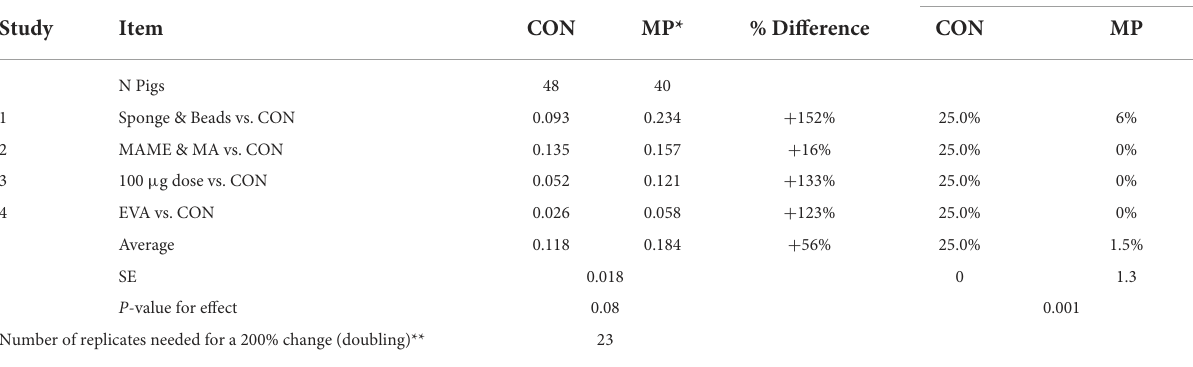
TABLE 7 Results of ADG and % of pigs losing weight from weaning until 7 days later over 4